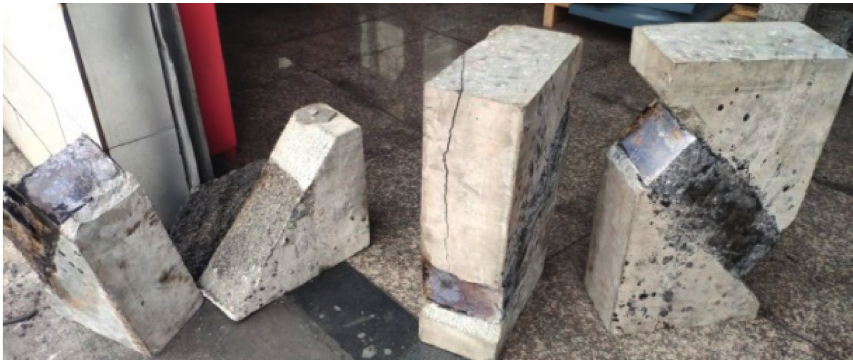
Figure 8: The failure mode of the slant shear test specimen.